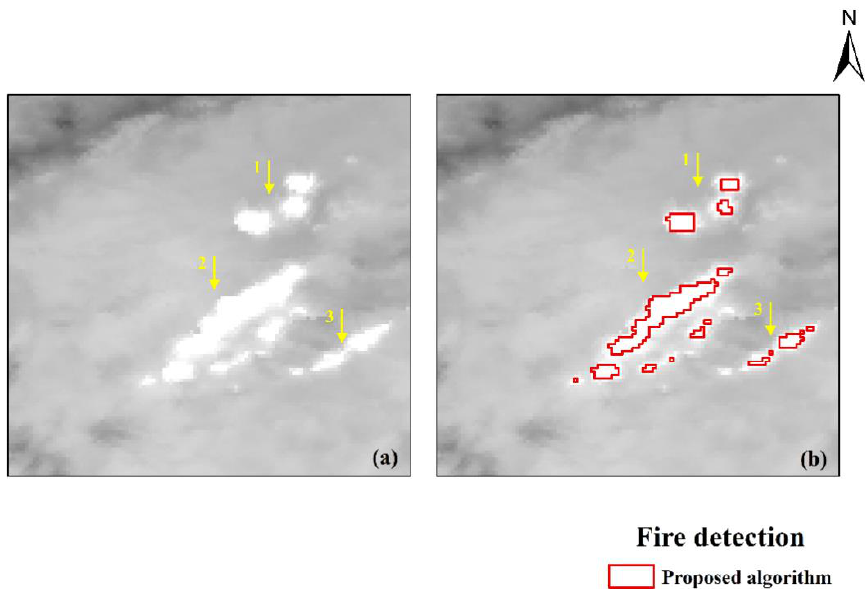
Figure 3. Fire detection results in Khabarovsk, Russia, on 16 April 2019. ( a ) MIR channel image; ( b ) Detection results of the proposed algorithm.